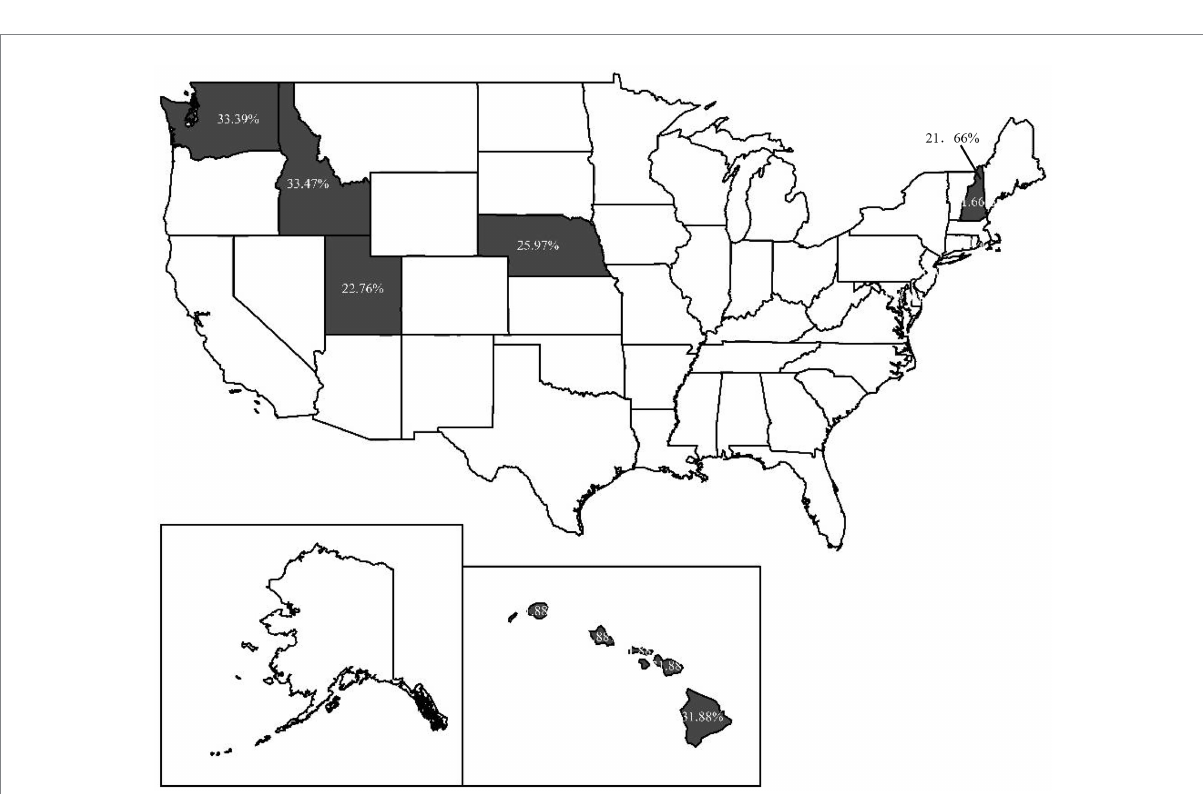
FIGURE 6 The distribution of the proportion of respondents with Y = 1 in